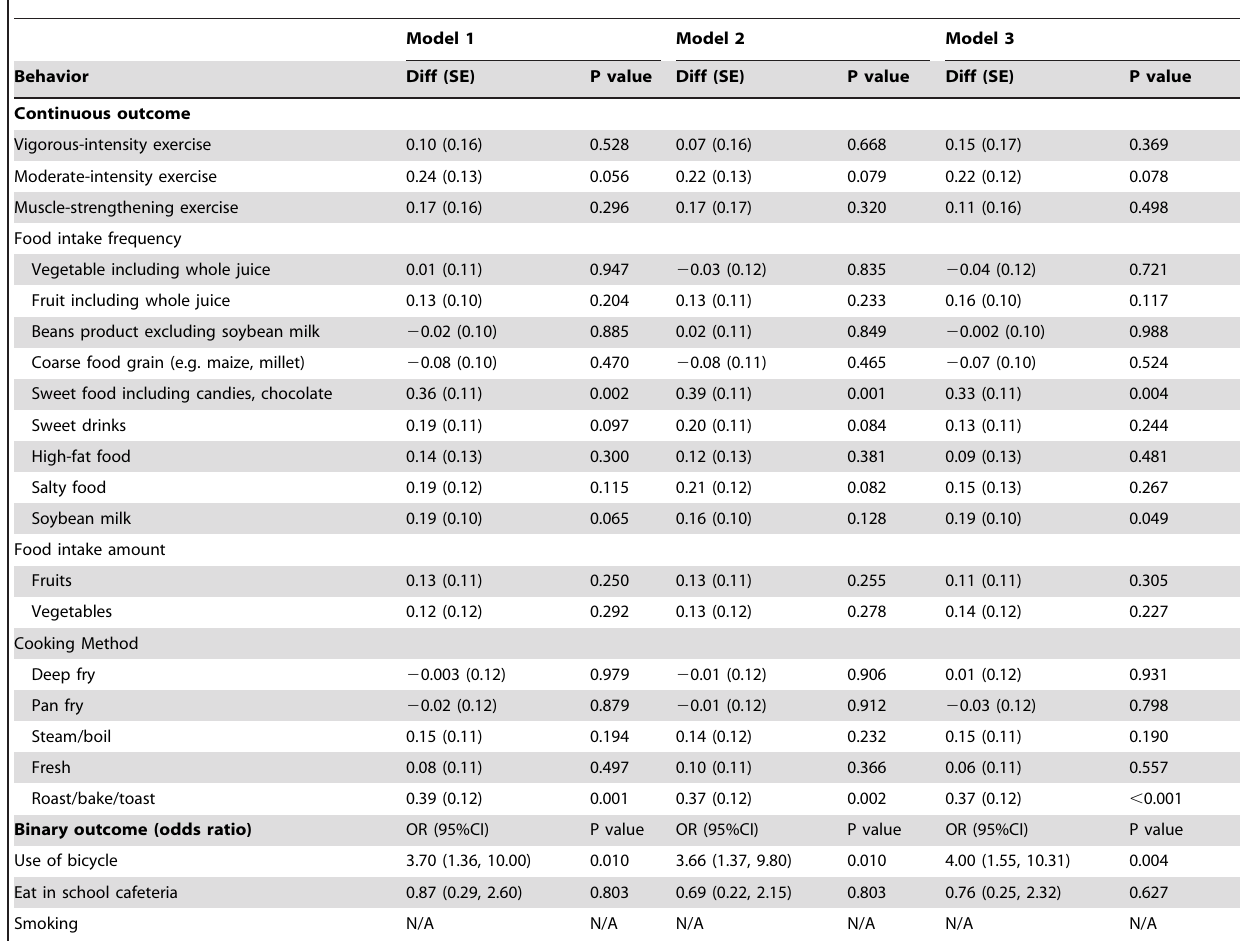
Table 3. Multivariate-adjusted point estimate and 95% confidence intervals for peer effects among